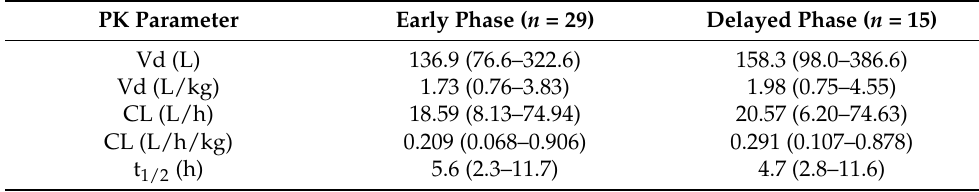
Table 2. Individual pharmacokinetic parameters of